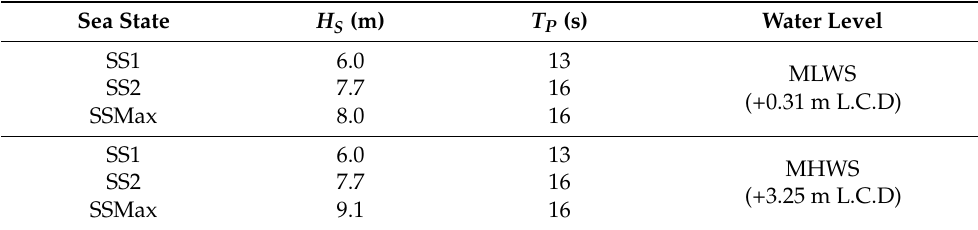
Table 1. Sea states tested for the assessment of overtopping flow and structural stability (prototype